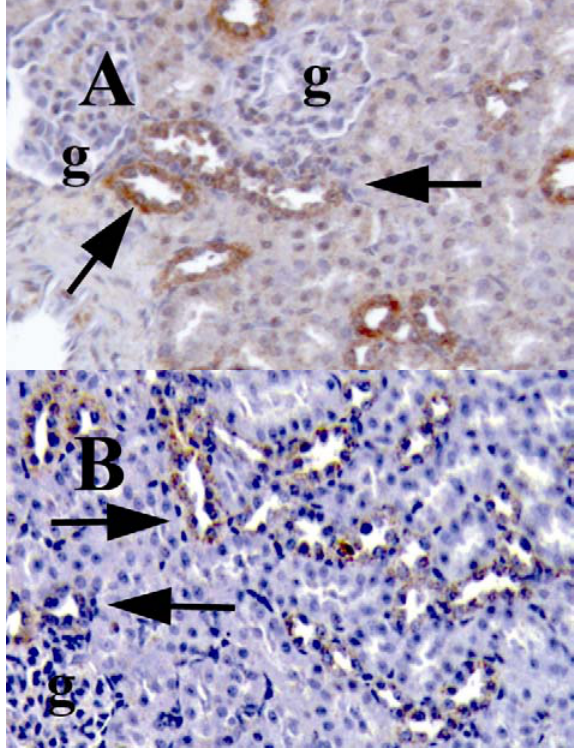
FIGURE 3 . Immunohistochemical staining of rat PN30 kidney using (A) a monoclonal anti-CTR antibody[17] and (B) an anti-RAMP 3 antibody (Alpha Diagnostic